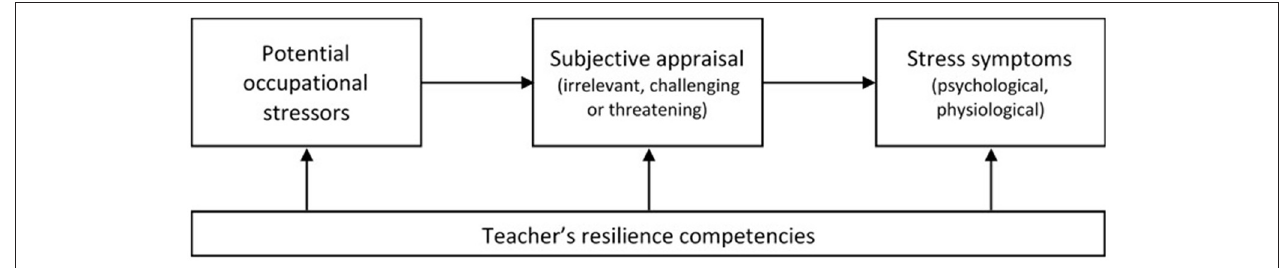
FIGURE 1 | Model of teacher stress according to Kyriacou and Sutcliffe